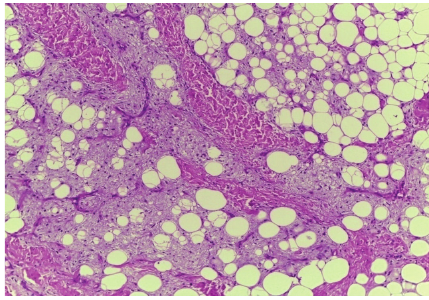
Figure 5: Histopathology of the specimen in Case 1. The tumour consists of mature adipose tissue and myxoid areas, with lacy network of small blood vessels (Hematoxylin and Eosin × 100).